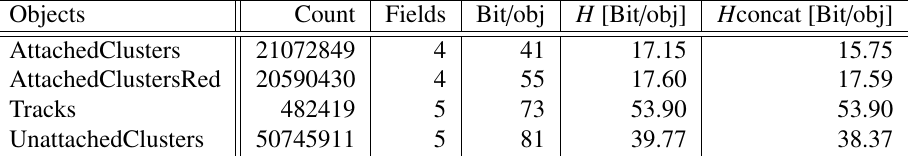
Table 1: Description of Sample Dataset. Entropy H of the samples can be reduced by con- catenation of correlated